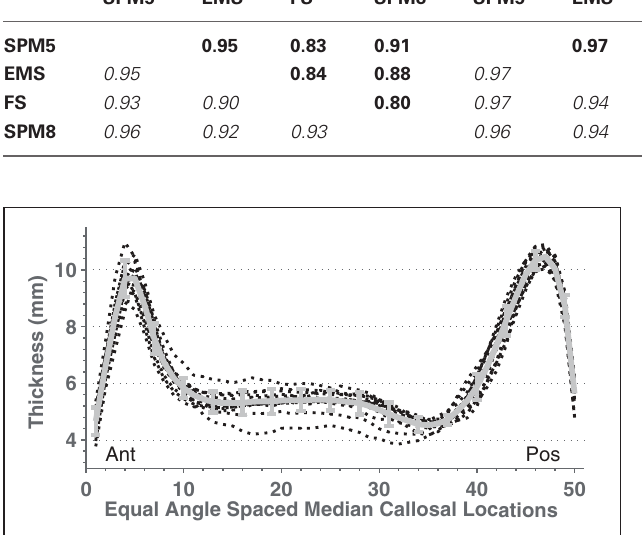
FIGURE 6 | Mean mid-sagittal callosal thicknesses from 14 different scanners (black dotted lines) with young (age means 21–33 years), mixed gender, healthy subjects taken from the FCP database (see Supplemental Table S1). The thick gray line shows the mean and standard deviation.